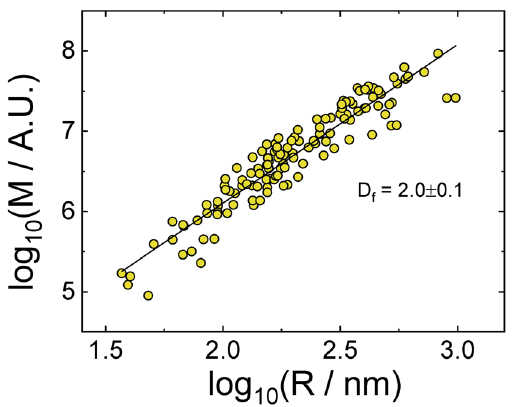
Fig. 9 Aggregate mass versus radius for the laboratory aerosol, determined from densitometric elaboration of TEM images. Solid line follows Eq. (1)